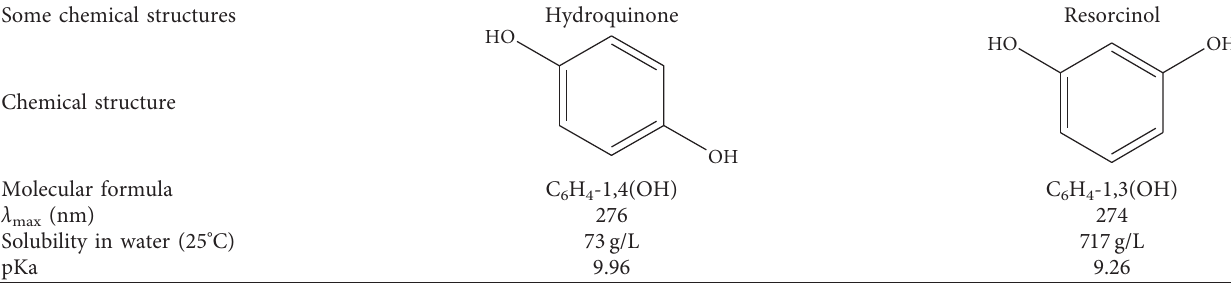
Table 1: Chemical structures and some properties of hydroquinone and resorcinol. Some chemical